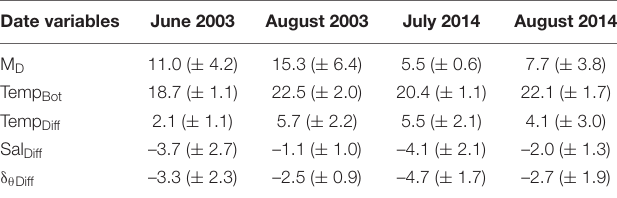
TABLE 2 | Mean ( ± SD) values of mixed layer depth (M D ; m) and bottom temperature (Temp Bot ; ◦ C), and difference between surface and bottom water of temperature (Temp Diff ), salinity (Sal Diff ), and density ( δ θ Diff ; kg m − 3 ) in different sampling periods of East China Sea.